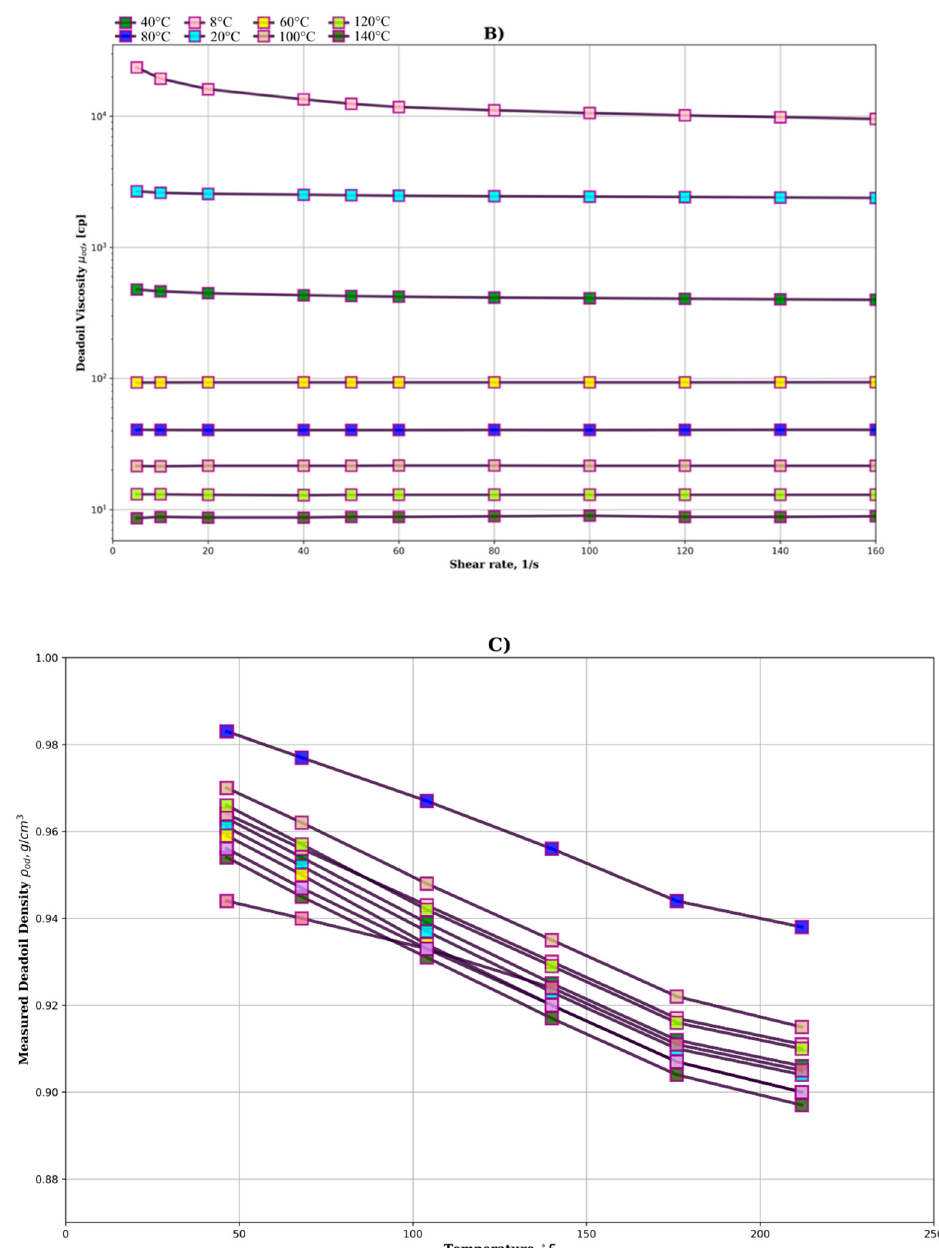
Figure 1. ( A ) Experimental results of 10 representative samples’ viscosity vs. temperature, ( B ) experimental results of one representative sample dead oil viscosity ( µ od ), cp in logarithmic format vs. shear rate ( γ ), 1 /c and ( C ) experimental results of one sample dead oil density ( ρ od ) vs. temperature ◦